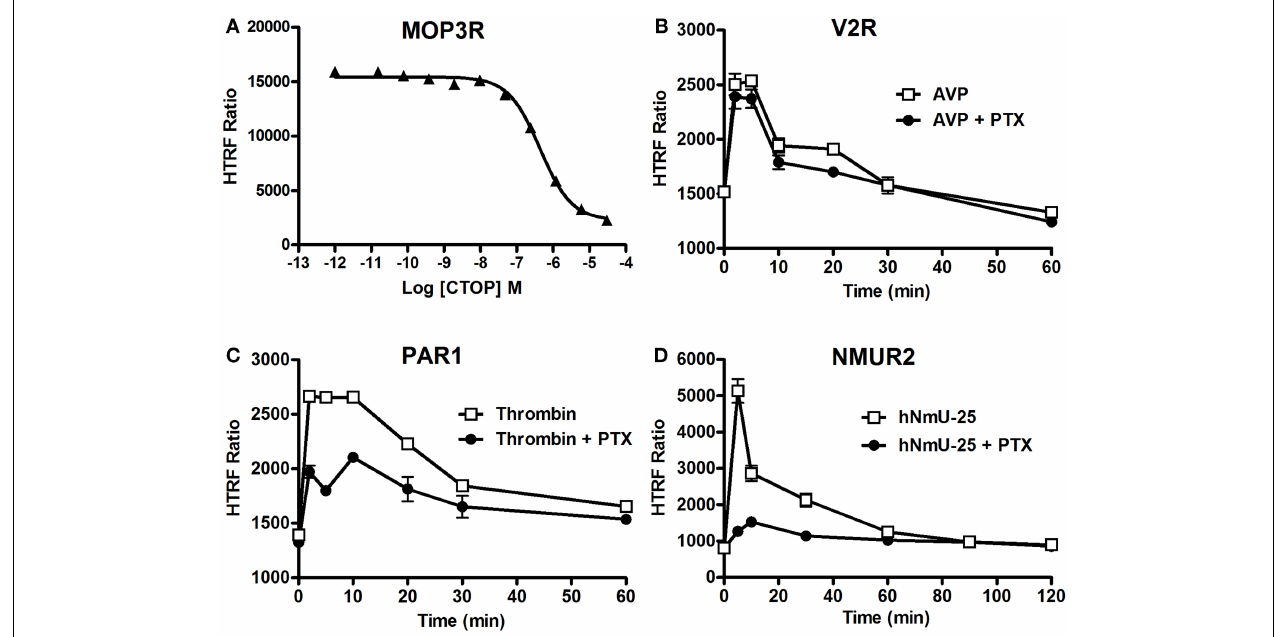
using 10 5 cells/well and the two-plate protocol.To assess the inhibition, cells were first pre-treated either with CTOP (A) for 15min or overnight with 200ng/ml of PTX (B–D) before agonist stimulation and HTRF measurements. The data are mean ± SEM of three independent experiments performed in